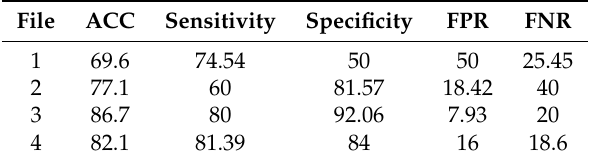
Table 2. SVM-subsystem performance in starting the